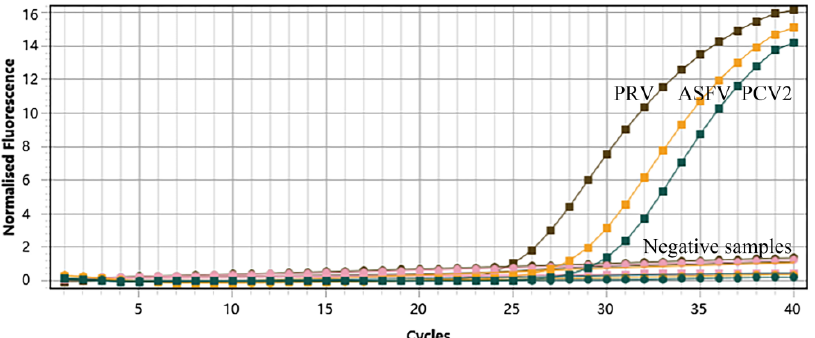
Figure 2. The amplification curves of specificity tests of multiplex real-time qPCR. Only ASFV, PCV2, and PRV exhibited positive fluorescence signals, while other swine pathogens exhibited no fluorescence signals.